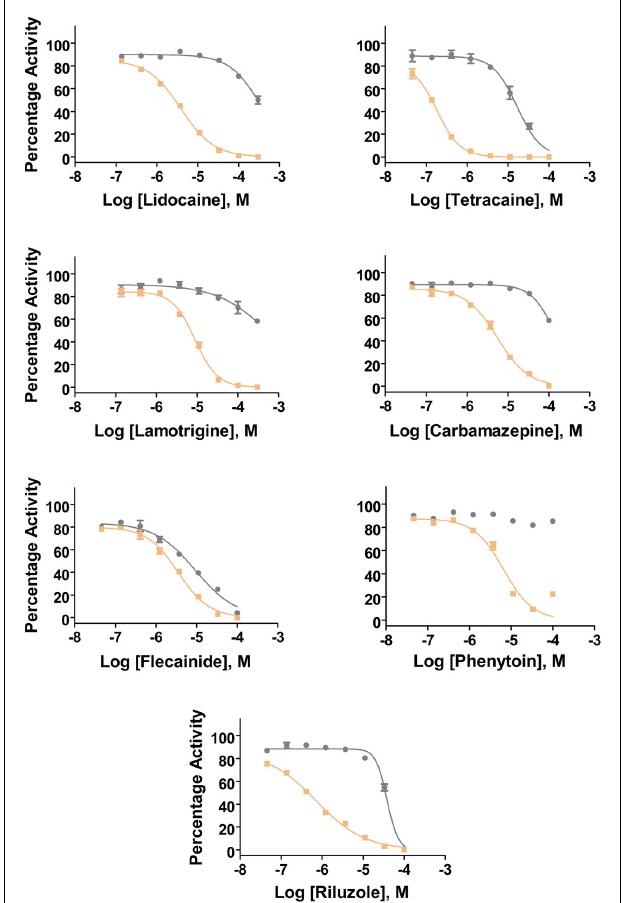
FIGURE 5 | Inhibition of Nav1.5 channels by Nav1.X channel standards using the inactivated-state IonWorks Quattro protocol (Figure 4). Pulse 1 (P1) and Pulse 2 (P2) data were calculated from the maximum inward Nav current amplitudes from each depolarizing pulse and are presented as percentage activation relative to the ratio of Post-Compound/ Pre-Compound pulses. Gray symbols and lines are data from P1, and tan symbols and lines are from